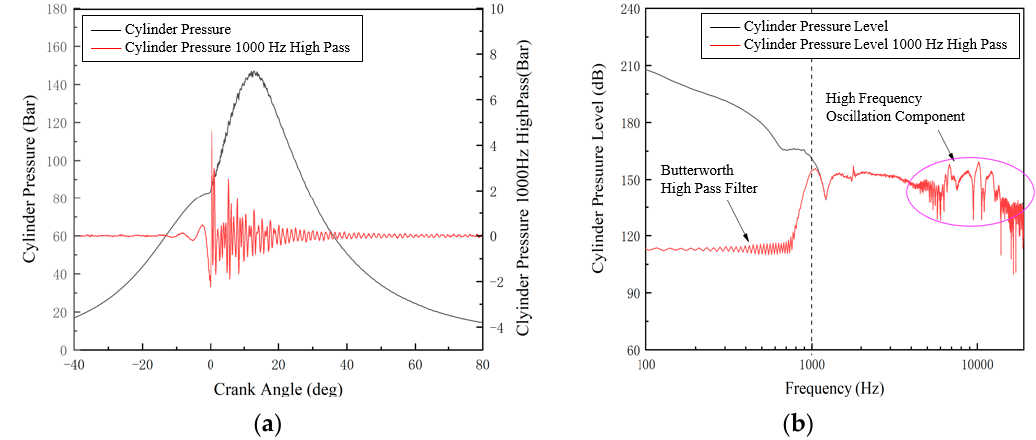
Figure 6. In-cylinder pressure signal and 1000 Hz high pass signal at 1400 r / min, full load condition: ( a ) in-cylinder pressure in angle domain; ( b ) in-cylinder pressure in frequency domain.